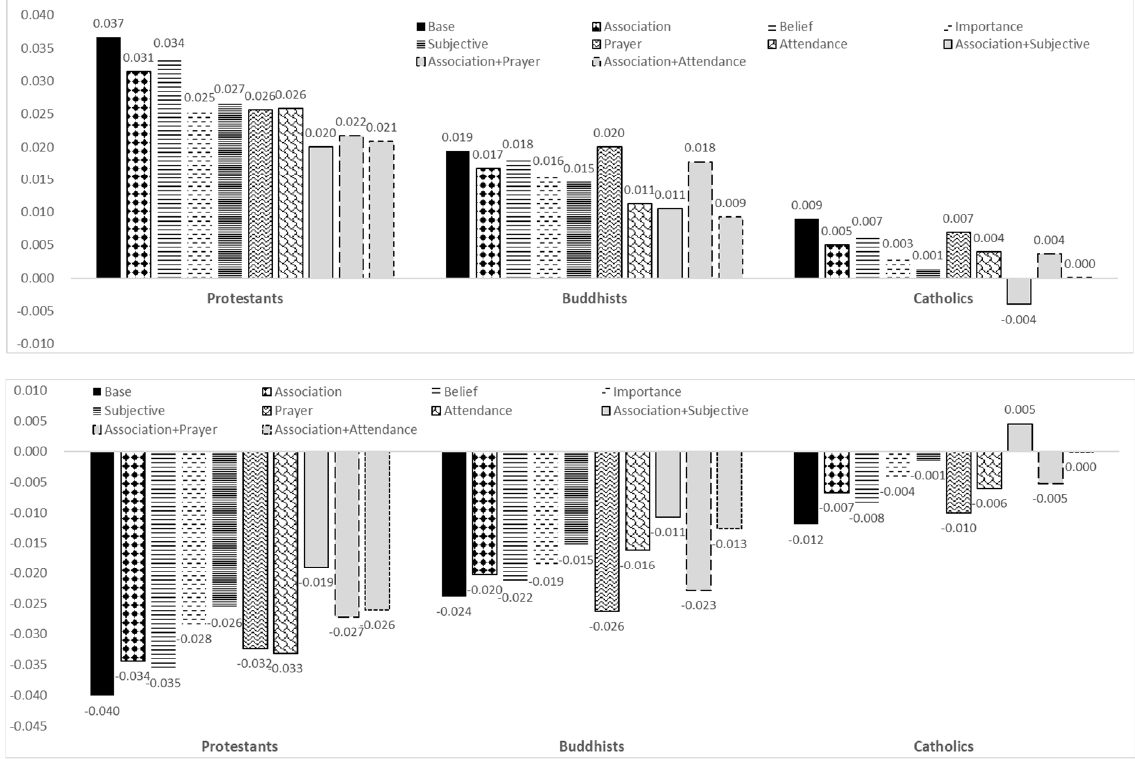
Figure 2. Differences in predicted probabilities of SOC being 10 (upper panel) and 5 (lower panel) among Protestants, Buddhists, and Catholics vis- à -vis non-affiliates. Note: Bars refer to the differences between affiliates (Protestants, Buddhists, or Catholics) and non-affiliates in the predicted probabilities for a hypothetical person (i.e., a mean-aged, college-or-more- educated, and married female who is a part-time worker with the mean income) to have SOC at 10 (the highest level) and at 5 (a low level). Bars of “Base” are post-estimations from Model 1 of Table 2; “Association” from Model 2; “Belief” from Model 3; “Importance” from Model 4; “Subjective” from Model 5; “Prayer” from Model 6; “Attendance” from Model 7; “Association + Subjective” from Model 10; “Association + Prayer” from Model 11; “Association + Attendance” from Model 12.